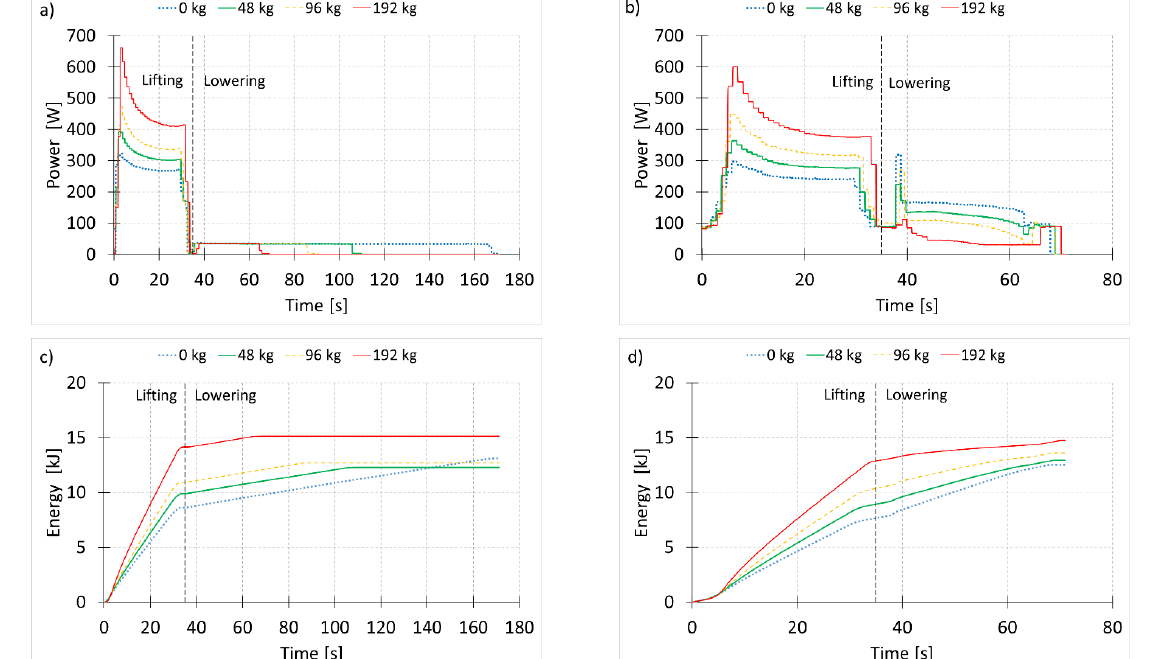
Figure 3. Comparison of the conventional drive (left) and EHD (right) in a duty cycle: ( a , b ) power consumption, ( c , d ) energy consumption.